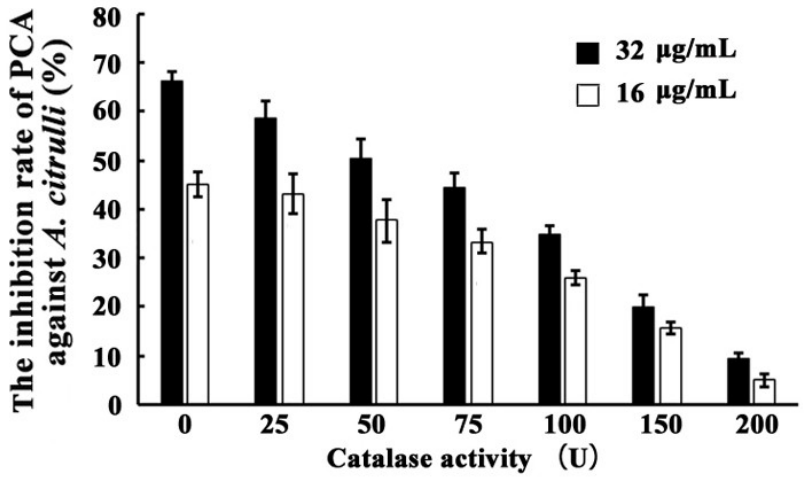
Figure 8. Inhibition effect of PCA against A. citrulli by adding exogenous CAT, 0, 25, 50, 75, or 100 U. The experiment was repeated three times.